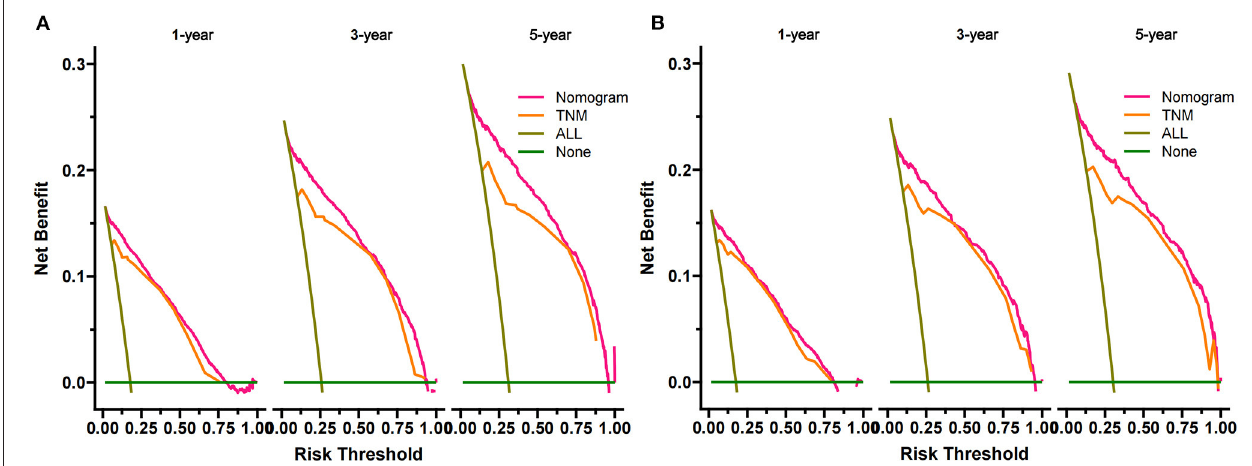
FIGURE 5 | DCA of the nomogram in the training cohort (A) and the validation cohort (B) . The Y-axis represents a net benefit, and the X-axis represents threshold probability. The green line means no patients died, and the dark green line means all patients died. When the threshold probability is between 0 and 100%, the net benefit of the model exceeds all deaths or none.